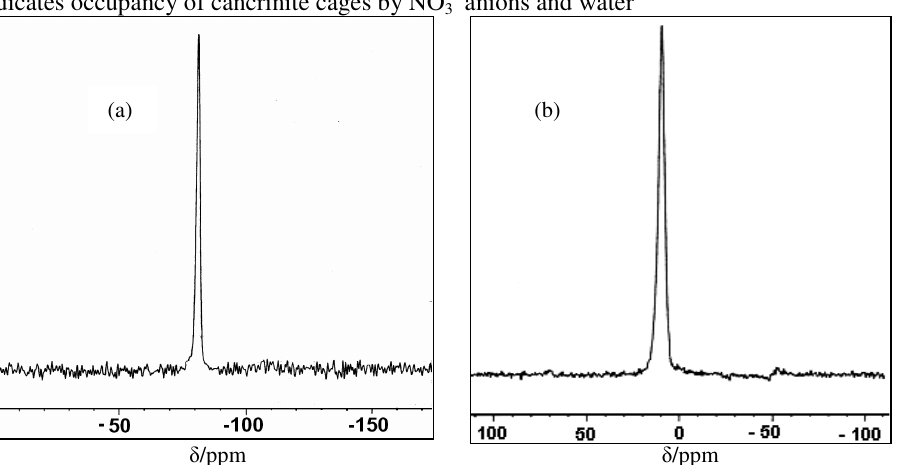
Figure 4. MAS NMR spectra of gallosilicate nitrate cancrinite (a) 29 Si MAS NMR (b) 23 Na MAS NMR.